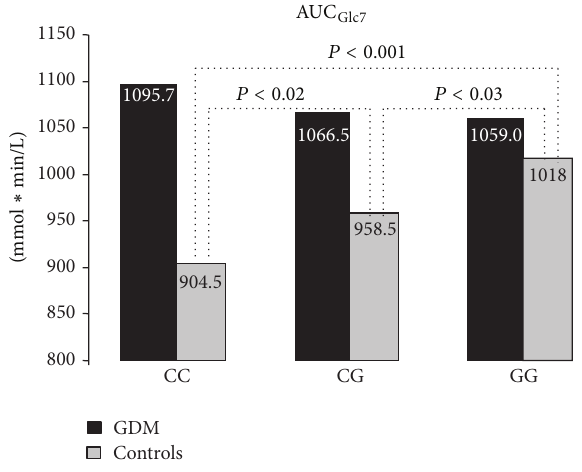
Figure 2: Area under the glycemic curve during the 7-point oGTT based on the MTNR1B SNP rs10830963